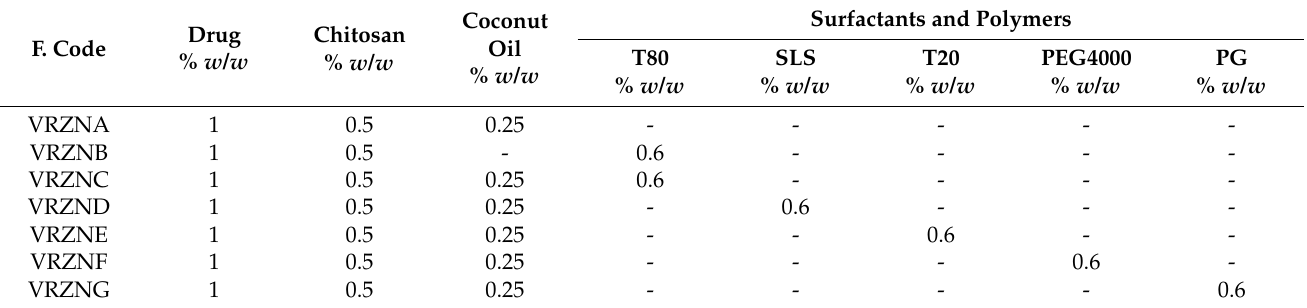
Table 1. Formulation composition (chitosan, voriconazole, coconut oil, T20, T80, SLS, PEG4000, and PG) of